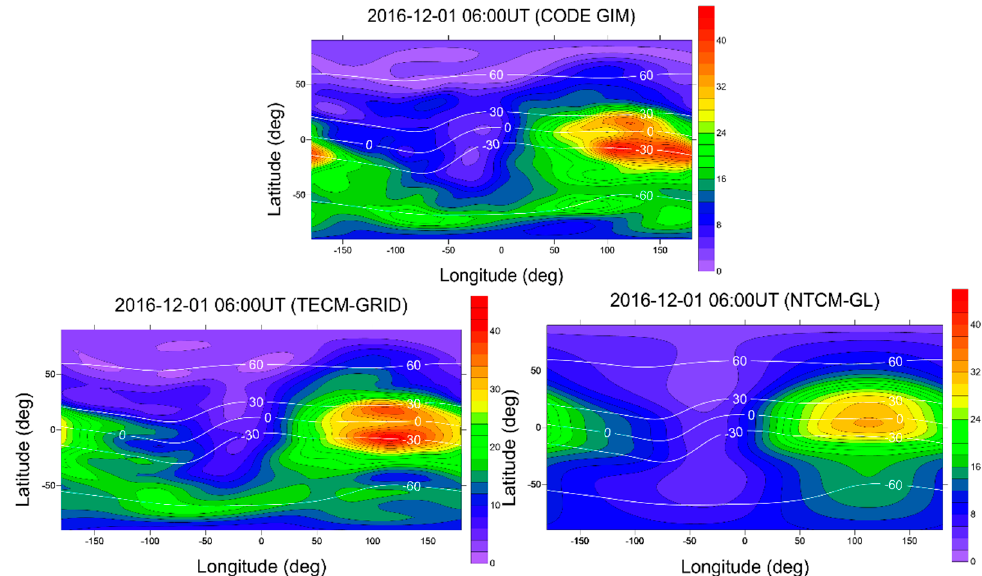
Figure 12. Comparison of TECM-GRID and NTCM-GL with the CODE GIM (1 October 2016).